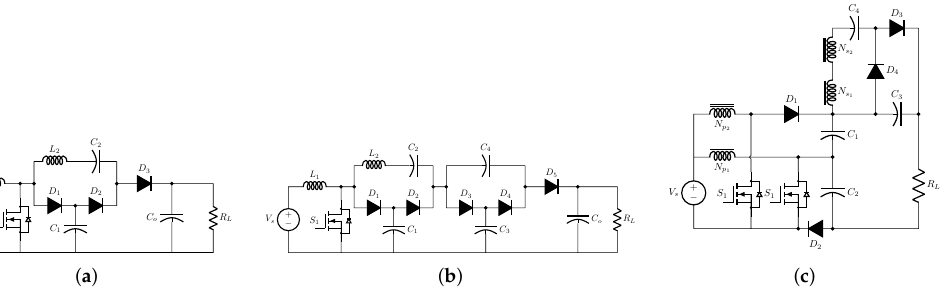
Figure 11. Voltage Multiplier Techniques. ( a ) Boost Converter with VMC M = 1, ( b ) Boost Converter with VMC M = 2, ( c ) I-Parallel O-Series Boost Converter with dual Coupled Inductor and